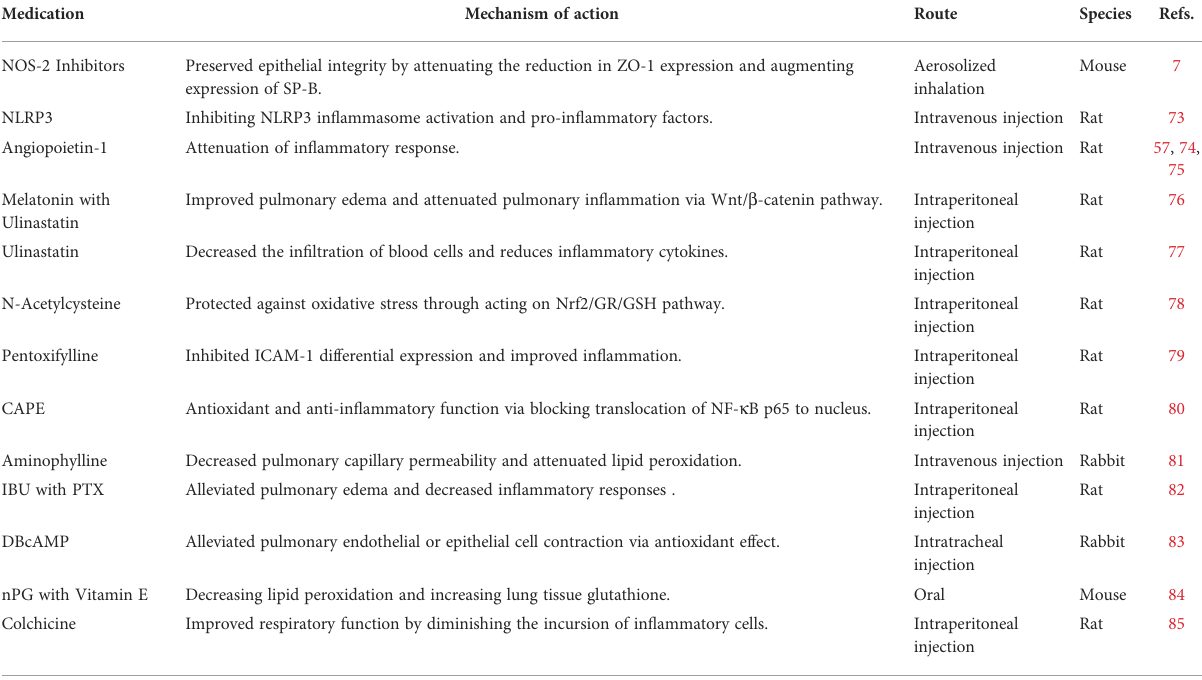
TABLE 1 Summary of the effects and mechanisms of pharmacological-mediated therapy the treatment of P-ALI. Medication Mechanism of